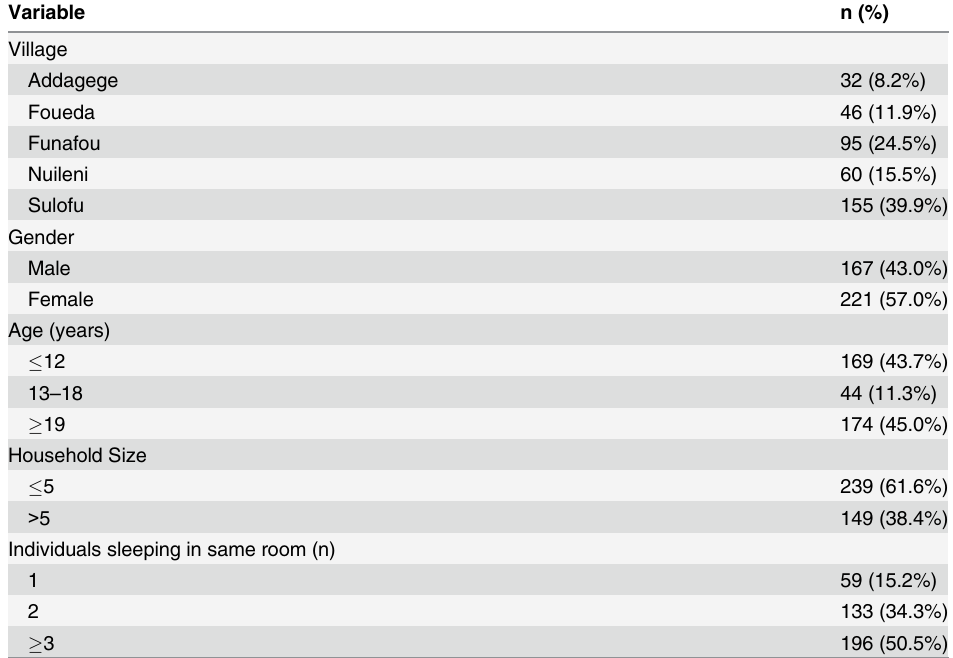
Table 1. Demographic